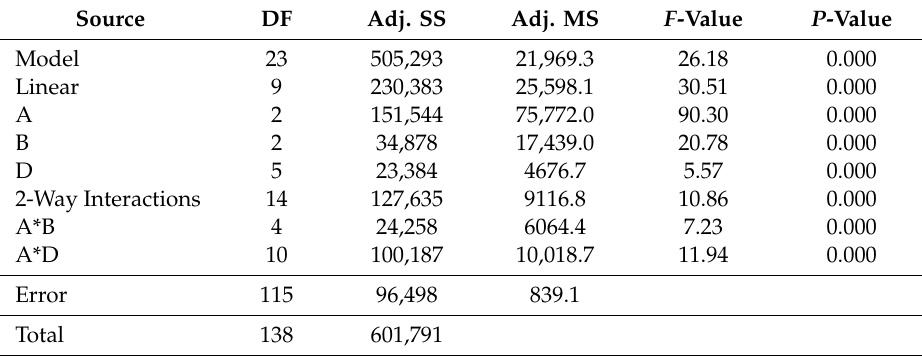
Table 8. Analysis of variance (ANOVA) for principal stress (two locking